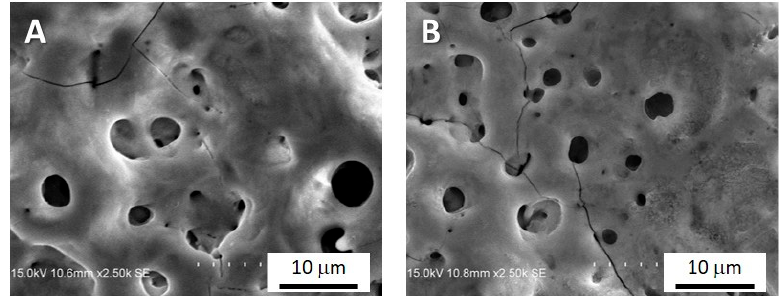
Figure 1. Scanning electron microscopy (SEM) images of specimens before ( A ) and after ( B ) incubation in saline during 28 days. These images show the connective porous oxide layer on a Titanium (Ti) surface formed by micro-arc oxidation (MAO) treatment using Zinc-containing electrolyte.